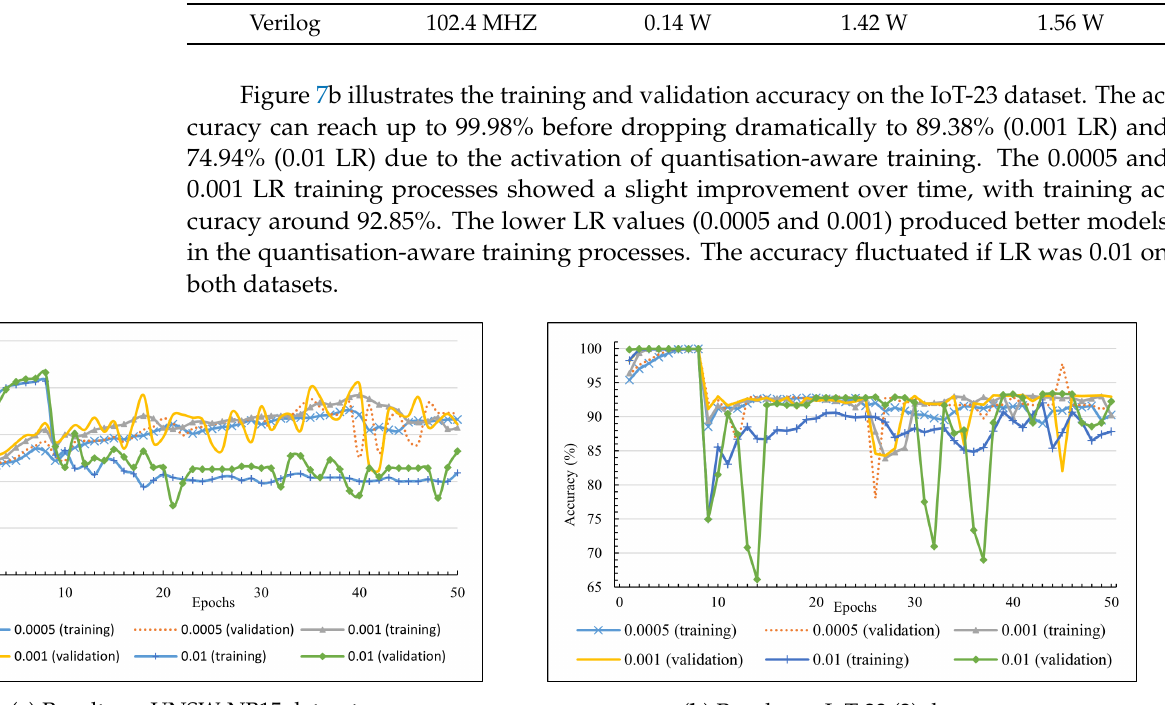
Figure 7. The trained results in fifty epochs with three different learning rates: 0.0005, 0.001, and 0.01 for the MAX78000